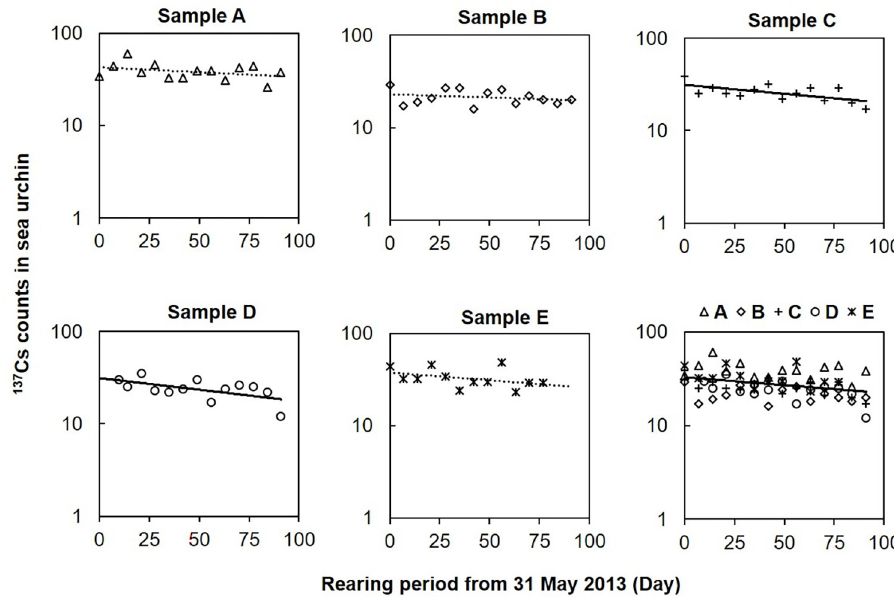
Fig 2. Temporal changes in the 137 Cs counts in five sea urchins during the rearing period (31 May–30 August 2013) in laboratory conditions. The solid and dashed lines represent statistically significant and insignificant regression slopes, respectively.